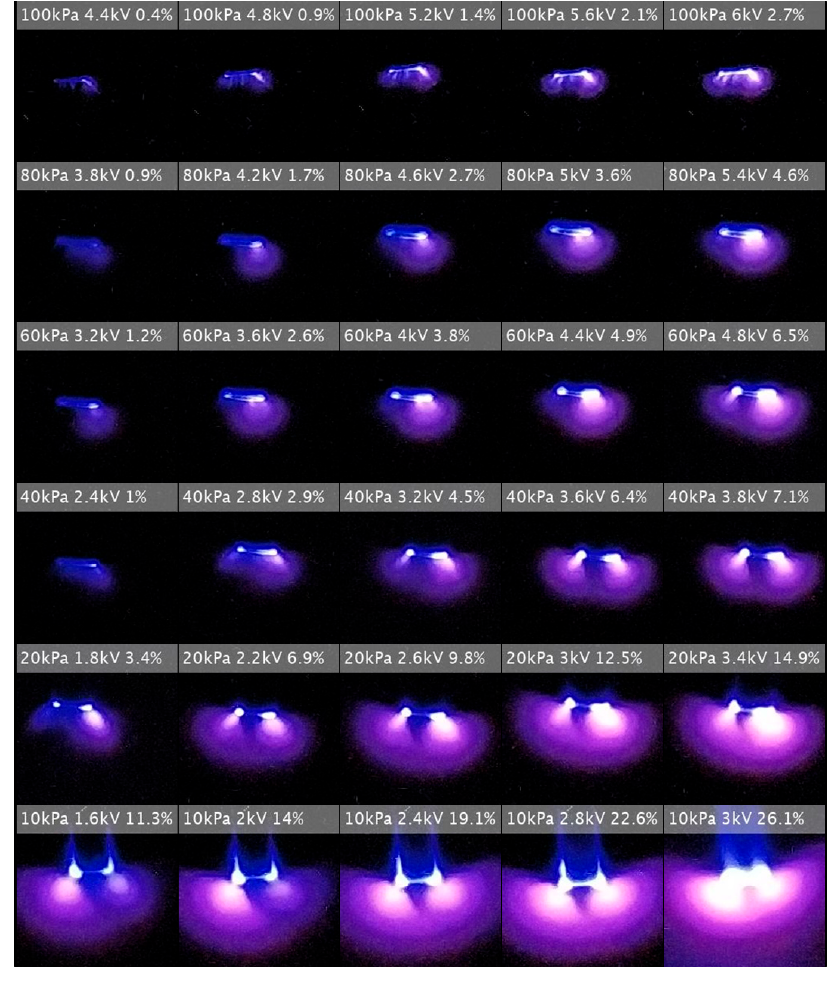
Figure 5. Long exposure photographs of the discharges under the experimental conditions de- scribed in the images (voltages expressed in RMS value). The images indicate the operating pres- sure, the applied voltage, and the value of the discharge severity indicator INT normalized .